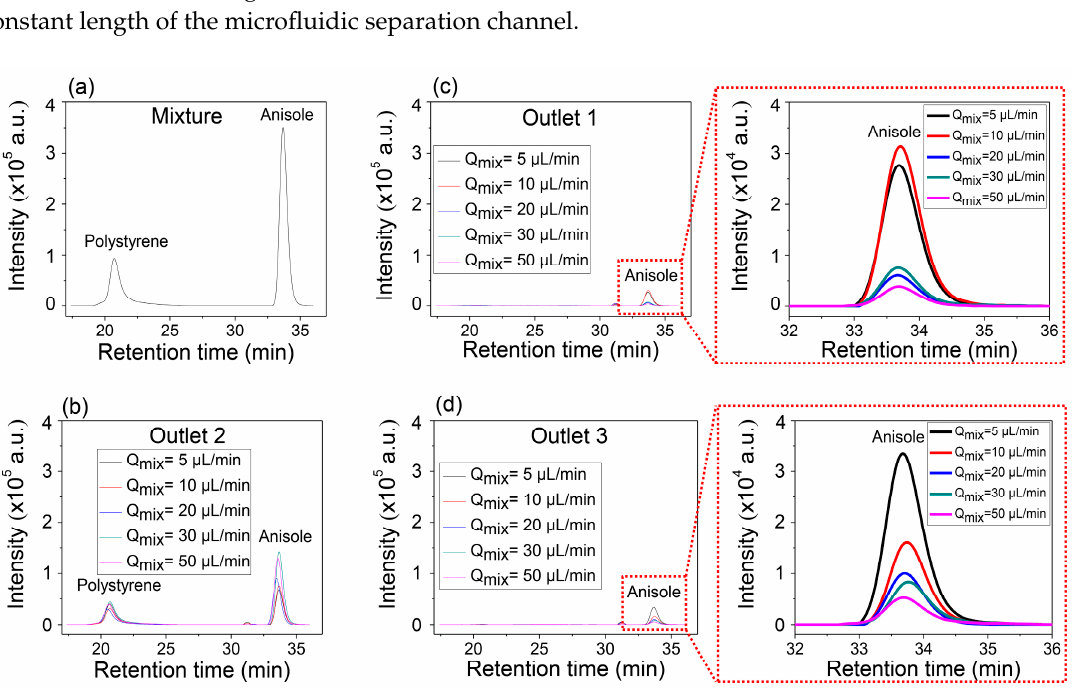
Figure 4. Selective continuous separation of anisole from the mixture of anisole with PS using gel permeation chromatography (GPC): ( a ) GPC analysis of the mixture; ( b ) GPC analysis of Outlet 2;